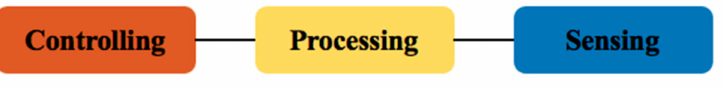
Figure 1. Structure of an adaptive sampling